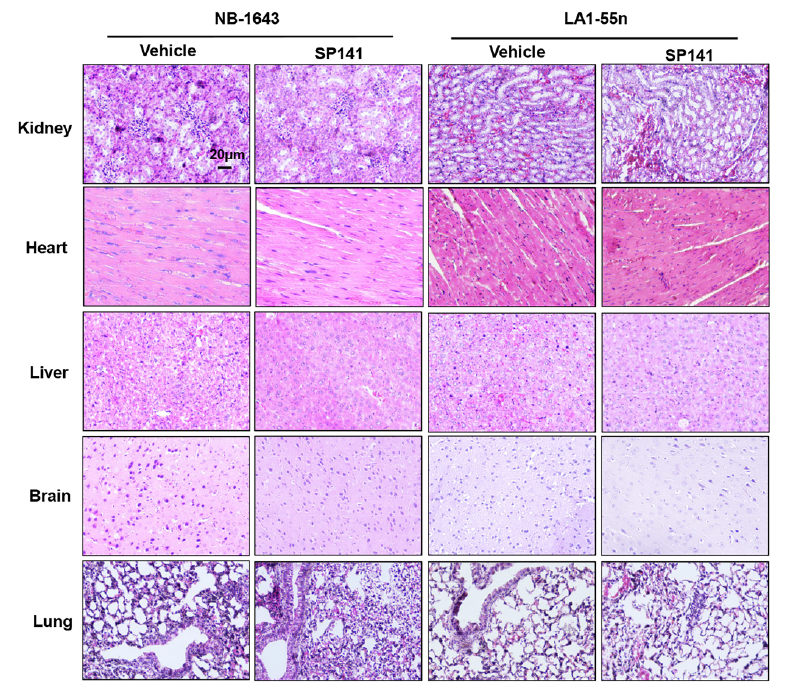
Figure 5. SP141 inhibits neuroblastoma xenograft tumor growth in vivo, without observable toxicity in the animals. Nude mice bearing NB-1643 or LA1-55n xenograft tumors were treated with SP141, which was administered by i.p. injection at 40 mg/kg/day, 5 d/week for 15 and 21 days, respectively. of major organs (kidneys, heart, liver, brain, and lungs) from mice bearing NB-1643 and LA1-55n xenograft tumors (scale bar, 20 µ